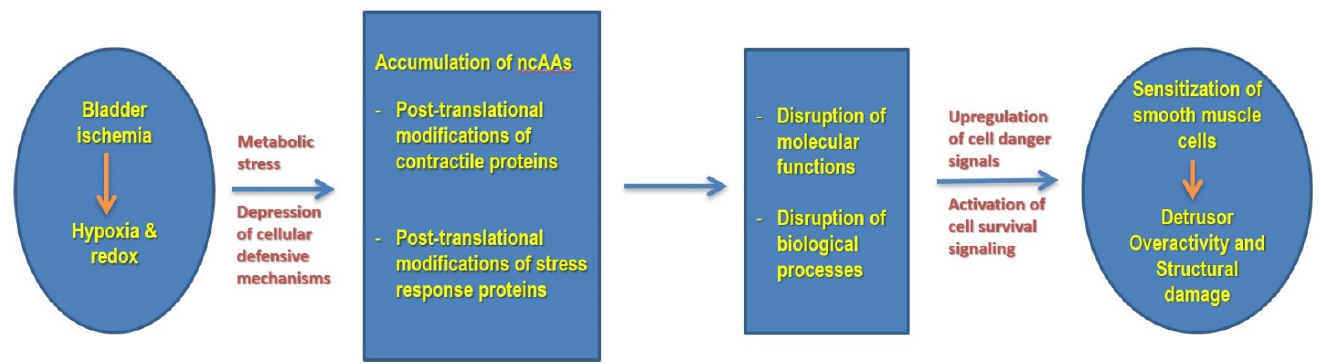
Figure 6. Graphical model of molecular and cellular consequences of post-translational modifications of contractile and stress response proteins in bladder ischemia. ncAAs: non-coded amino acids.